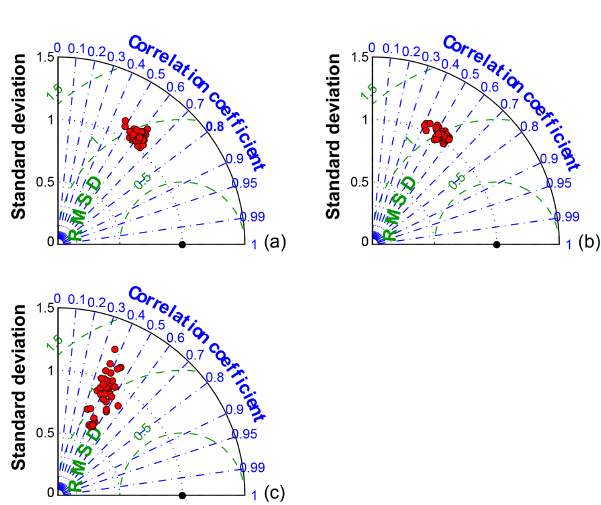
Figure 4. Taylor diagram comparing the 00:00UTC rawinsonde observations (300m wind speed a , 300m wind direction b and PBLH c ) to the 45 model configurations (red